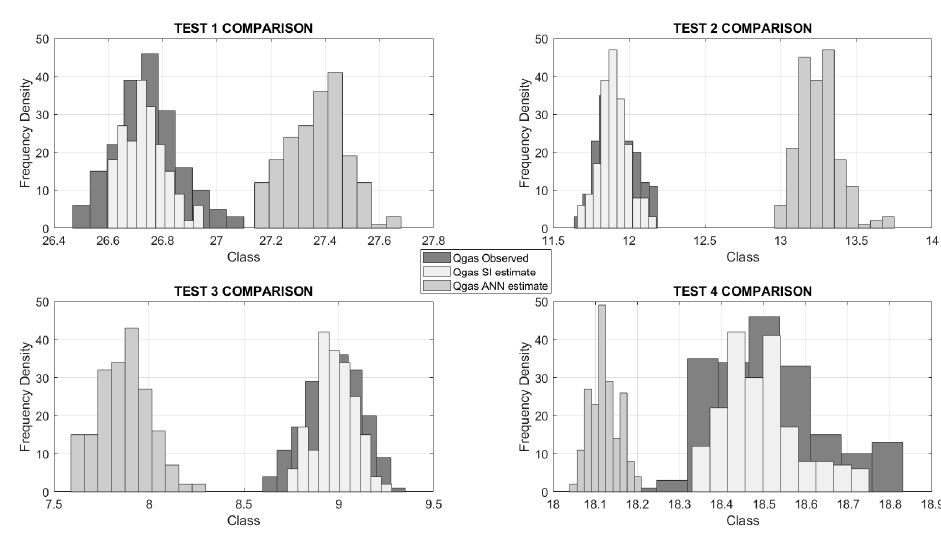
Figure 11. Comparison of the observed Qgas values and the estimated ones.